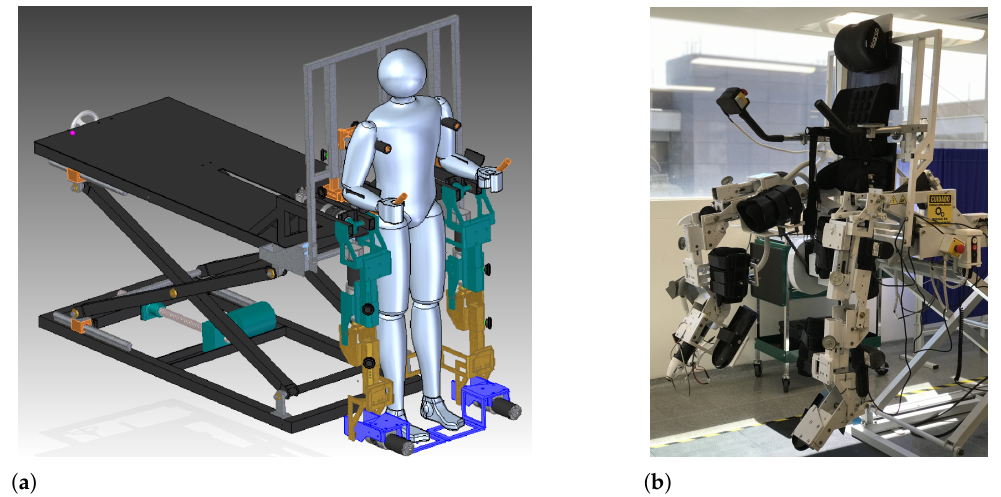
Figure A1. Nukawa, a 3-DOF Lower-limb robotic rehabilitation for hip, knee, and ankle joints. ( a ) CAD model and ( b ) current version of the robot with both